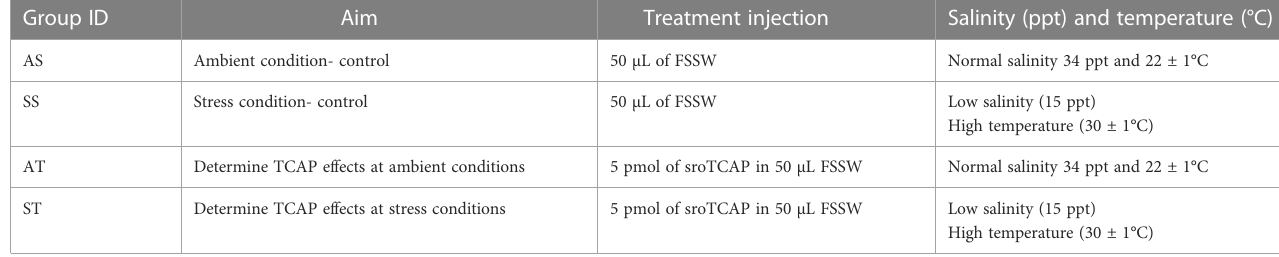
TABLE 1 Summary of oyster treatments (injection and incubation conditions) used in the heart transcriptome analysis (n=6 per group). Group ID Aim Treatment